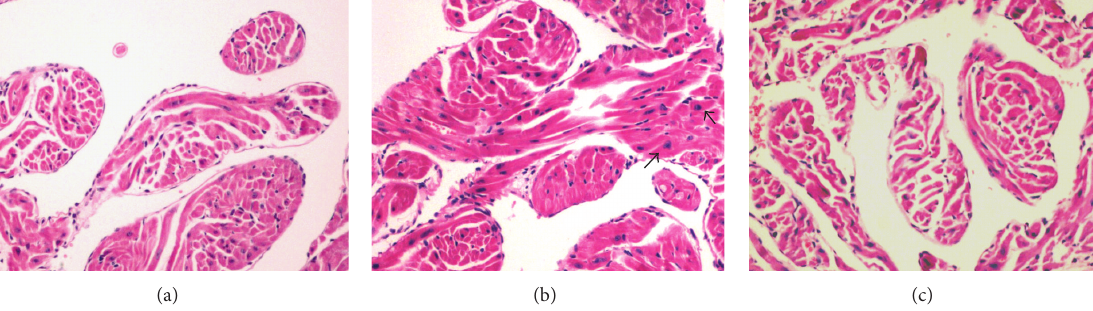
Figure 3: H&E staining of LV myocardium after 10 weeks: (a) control group, (b) DM group, and (c) DMT group. Magnification, 400x. Arrows indicate the hypertrophic cardiomyocytes with enlarged nuclei.